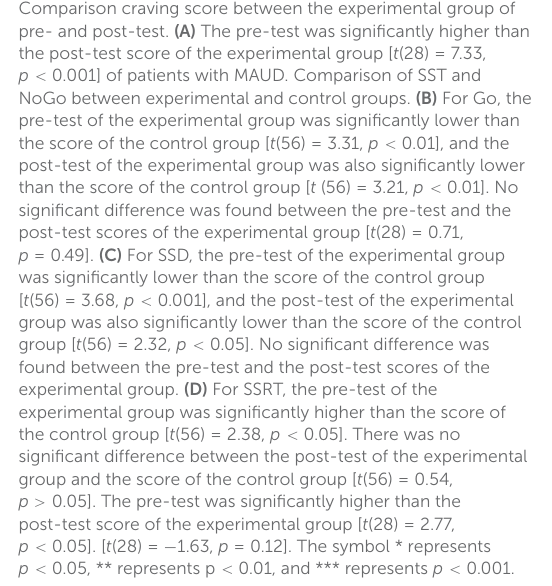
( r = 0.03, p > 0.05), pre- ( r = − 0.08, p > 0.05), post-Go ( r = − 0.13, p > 0.05), pre- ( r = − 0.28, p > 0.05),